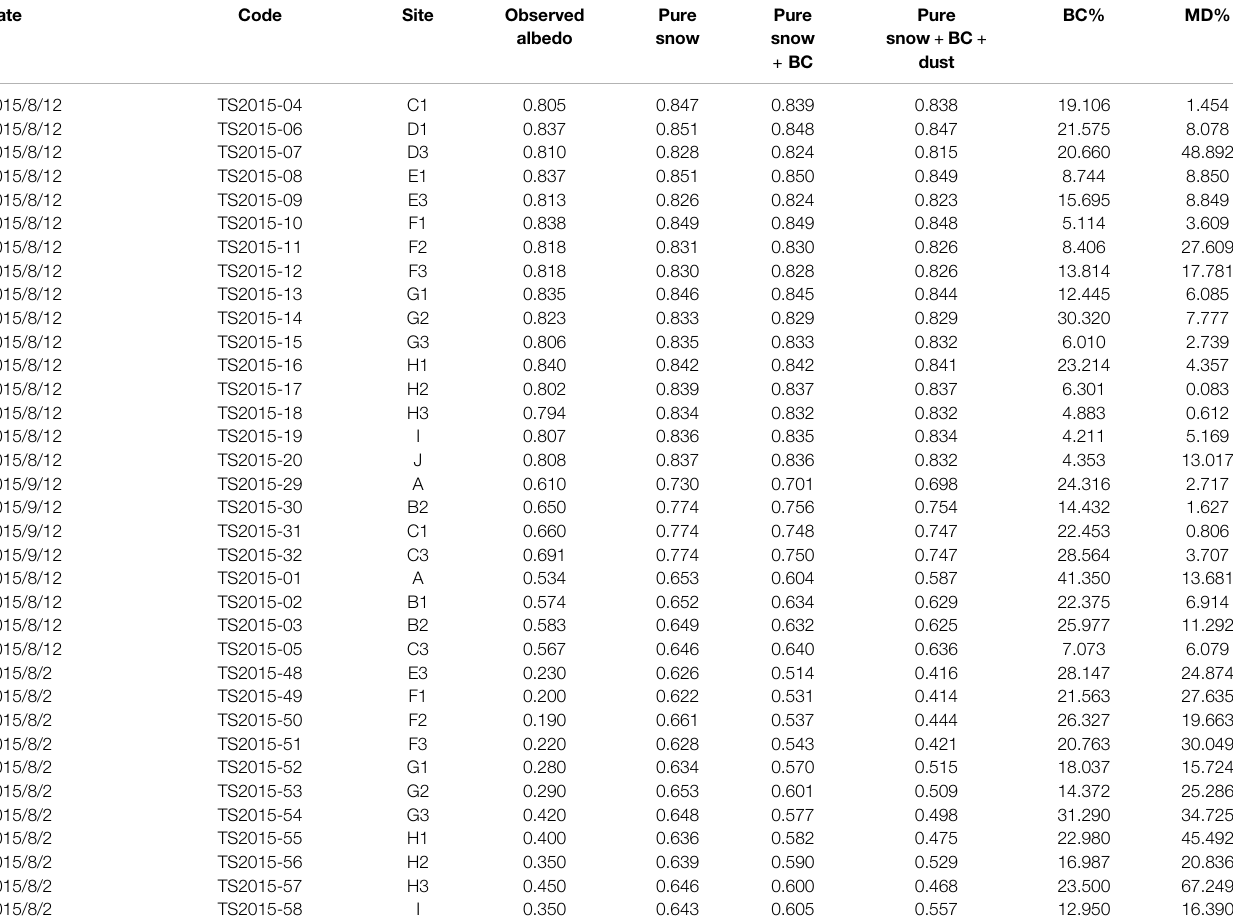
TABLE 3 | Parameters for sensitivity analysis with the SNICAR model for Urumqi Glacier